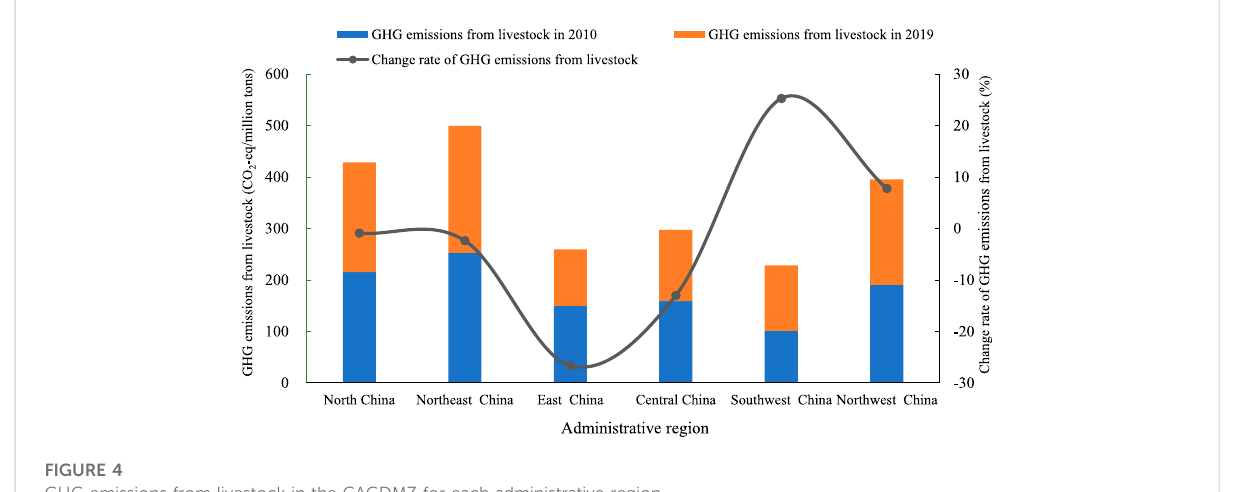
FIGURE 4 GHG emissions from livestock in the CAGDMZ for each administrative